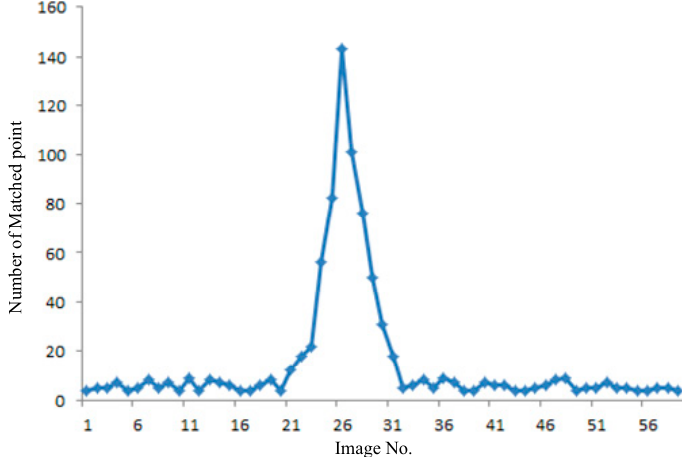
Figure 6. Fast search and large file location based on spatial query.